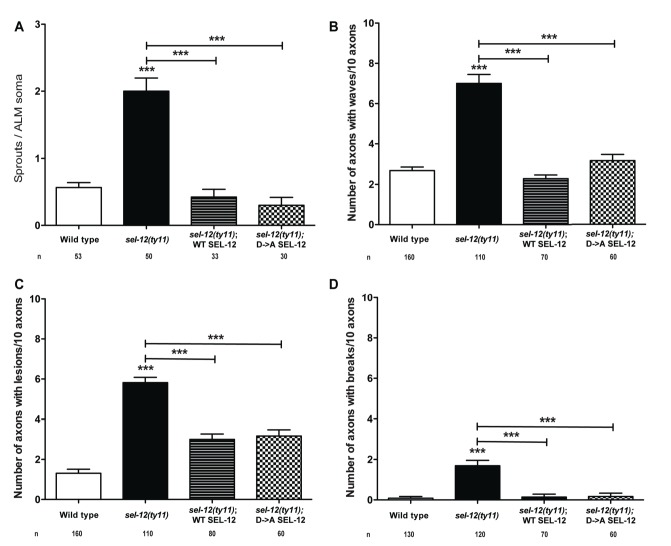
Loss of gamma-secretase function does not result in neurodegenerative morphologies.(A) Quantification of aberrant structures (sprouts/branches) on ALM neuronal soma of wild type, sel-12(ty11) and sel-12(ty11) animals expressing wild type or a protease dead SEL-12 at day 1 of adulthood. Quantification of wave-like processes (B), lesions (C) and breaks (D) in ALM and PLM neuronal processes of wild type, sel-12(ty11) and sel-12(ty11) animals expressing wild type or a protease dead SEL-12 at day 1 of adulthood. Neuronal morphology analysis is done using transgenic animals expressing mec-4p::GFP (zdIs5). n = number of animals analyzed per genotype. Data are displayed as mean ± SEM, and all comparisons have been made to wild type animals unless otherwise indicated. ***p<0.0001 (One way ANOVA with Tukey test).10.7554/eLife.33052.012Figure 4—figure supplement 1—source data 1.Raw data for Figure 4—figure supplement 1.